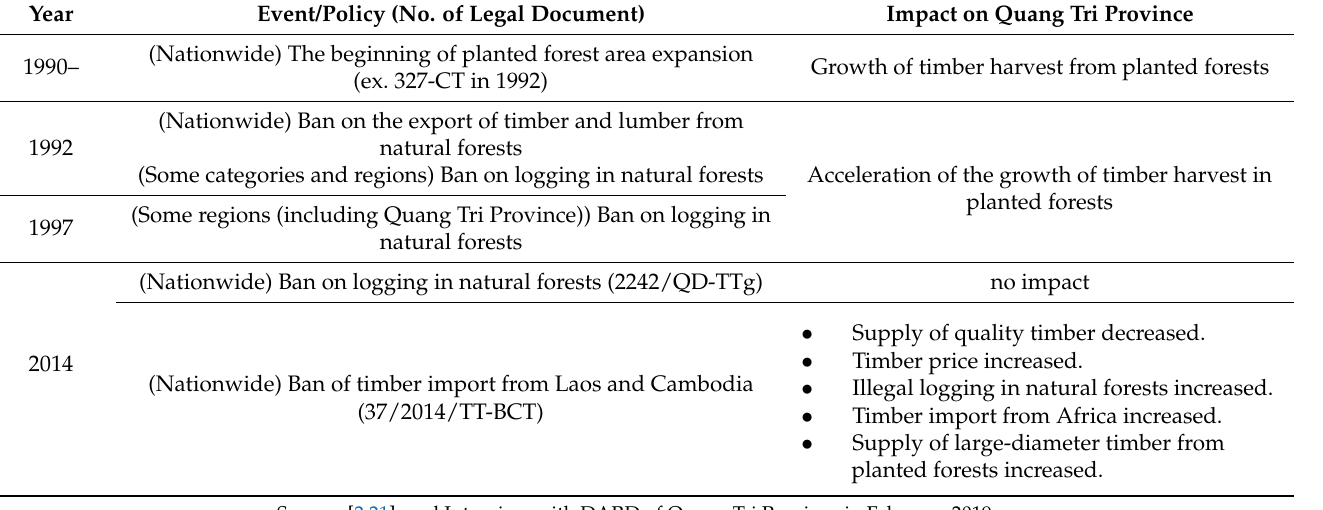
Table 1. Impact of each event and policy on the forests, forestry, and wood industry in Quang Tri Province. Year